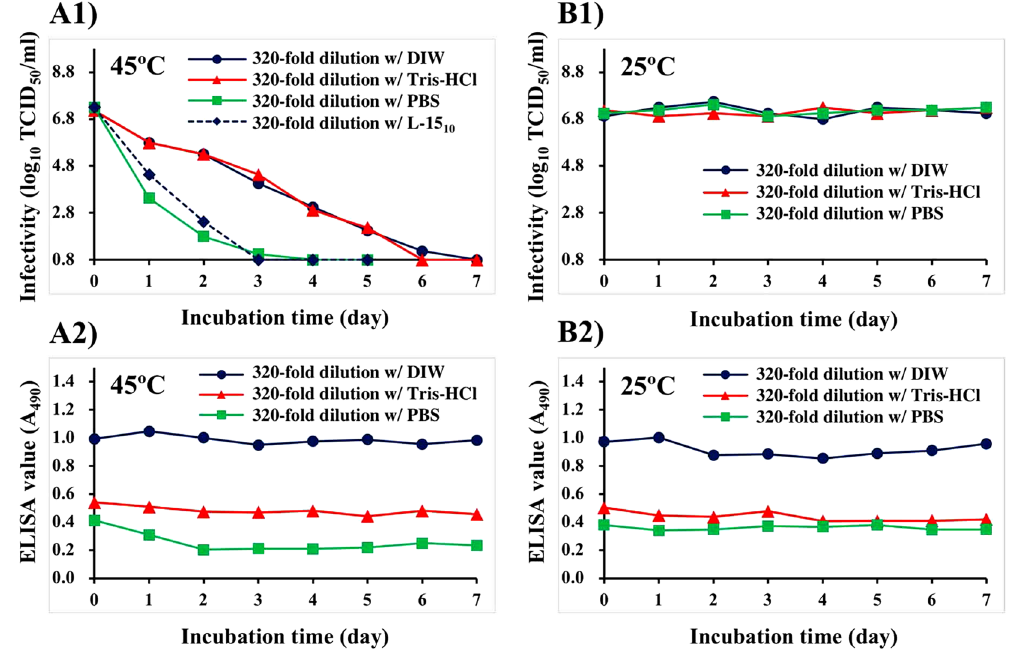
Figure 2. Effect of dilutions with deionized water (DIW), Tris-HCl (15 mM, pH 8.0), or PBS on infectivity and antigenicity of cultured NNV suspensions. Cultured NNV suspension was diluted 320-fold with DIW, 15 mM Tris-HCl (pH 8.0), or PBS, followed by incubation at 25 °C or 45 °C for up to 7 days. ( A ) Incubation at 45 °C, ( B ) Incubation at 25 °C (control). (1) NNV infectivity, (2) NNV